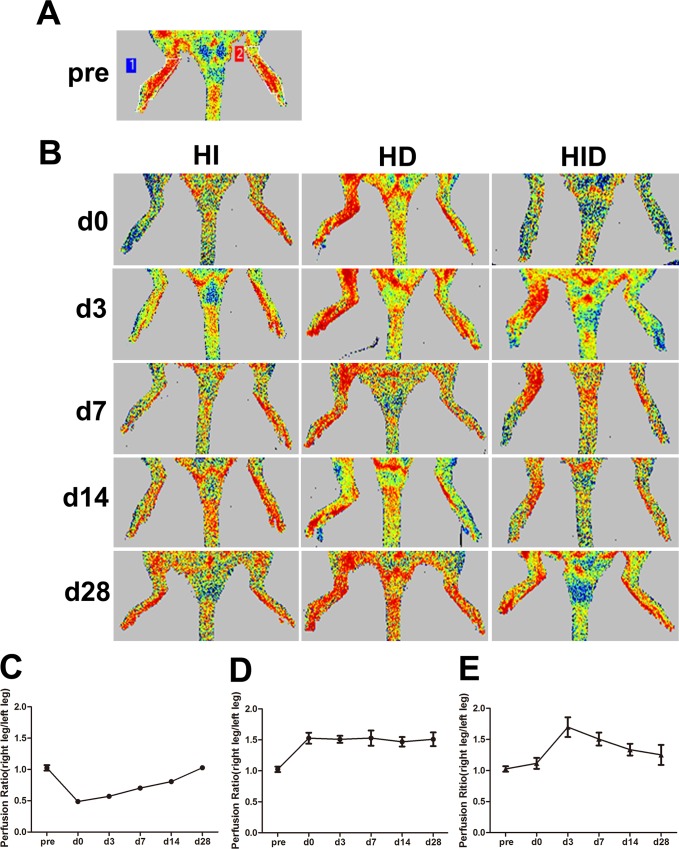
Perfusion recovery.Perfusion recovery is shown by laser Doppler perfusion images (A and B). Perfusion was evaluated in the plantar feet in the same anatomically defined region (shown as A) in all animals (n = 5 per group). The right leg/left leg perfusion ratio of group HI (C), group HD (D) and group HID (E) are shown. In group HI, perfusion ratio fell from 1.02 on baseline to 0.48 immediately post-surgery, but the ratio gradually increased within 28 days and the ratio returned to 1.03 on day 28 post-surgery. In group HD, the perfusion ratio was significantly elevated to 1.47–1.53 immediately post-surgery and each time point within 28 days. In group HID, the perfusion ratio slightly elevated immediately post-surgery and peaked to 1.69 on day 3 but decreased gradually after that and the ratio dropped to 1.25 on day 28 post-surgery.